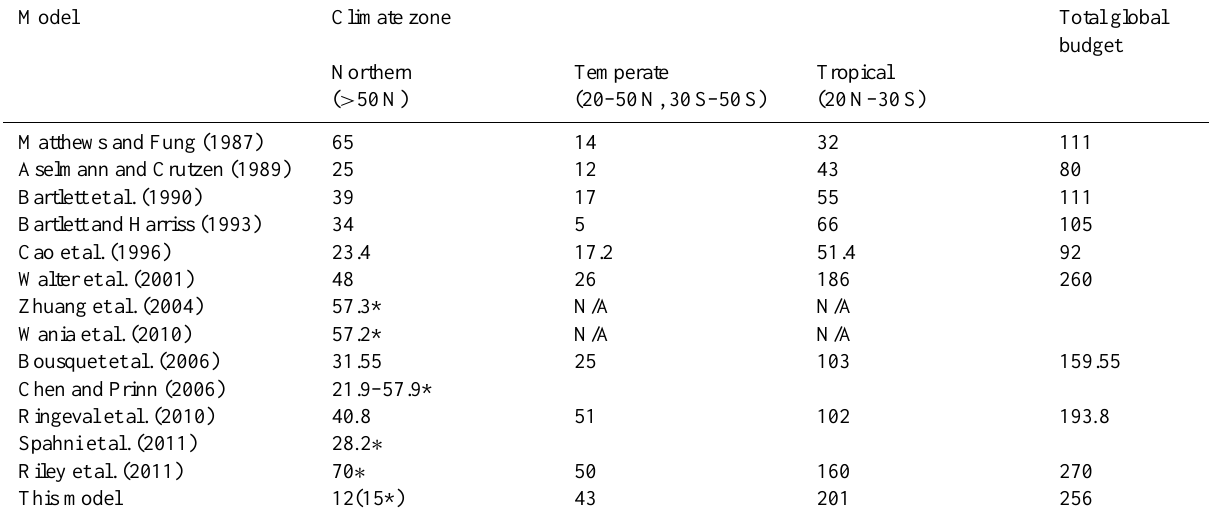
Table 6. Comparison of global wetland methane estimates between our model and other models. Model